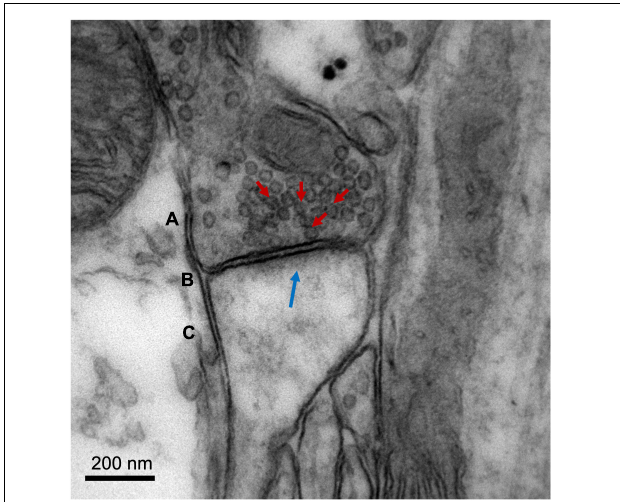
FIGURE 2 | Image of a cortical glutamatergic synapse of an adult C57BL/6 mouse. The image was obtained on a Jeol 1010 transmission electron microscope (Jeol, Tokyo, Japan) at 80,000 × magnification. (A) Presynaptic neuron, with synaptic vesicles indicated with red arrows. (B) Synaptic cleft. (C) Dendritic spine of a postsynaptic neuron, with postsynaptic density (electron-dense zone juxtaposed to the postsynaptic membrane) indicated with a blue arrow. Image courtesy of Nuria García Font, see García-Font et al. (2019) for more information about the methodology.